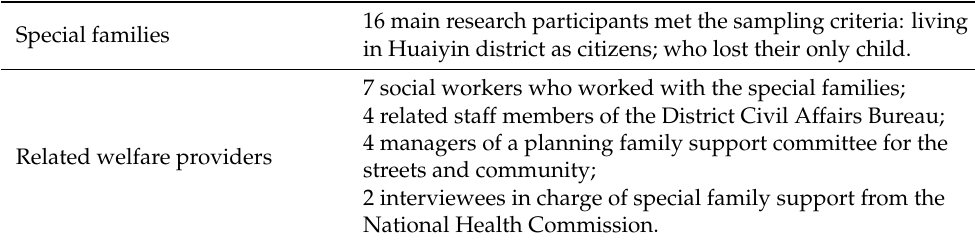
Table 1. Basic information of the